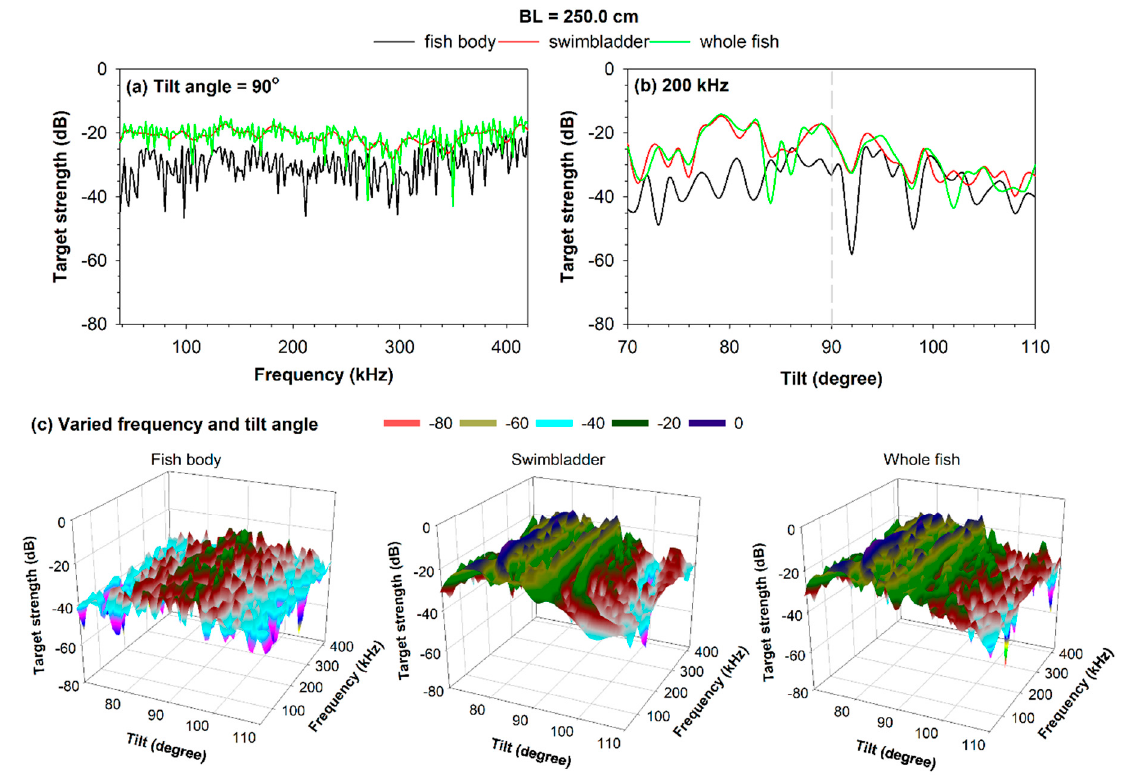
Figure 7. Expected TS model of an adult Chinese sturgeon with the representative body length of 250.0 cm: ( a ) TS as a function of frequency; ( b ) TS as a function of tilt angle; and ( c ) TS as a function of frequency and tilt angle.